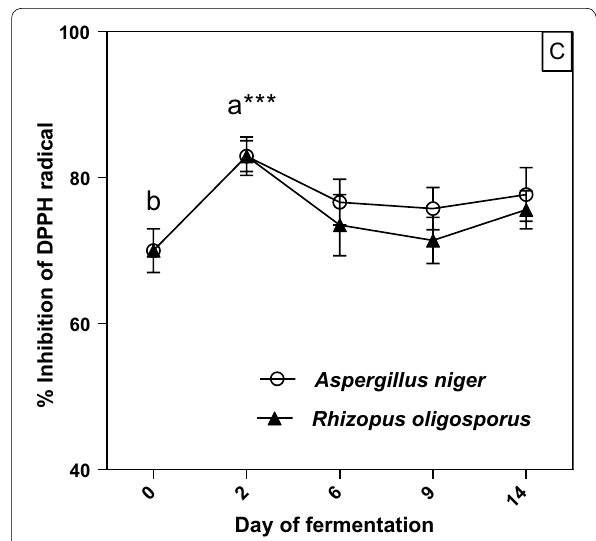
Fig. 4 Free radical scavenging activity (DPPH assay) of phenolics in extracts from solid state fermented apricot pomaces. Values are mean SD of triplicate determinations and different letters (a, b) ± indicate significant differences (p < 0.05) (paired t‑test)